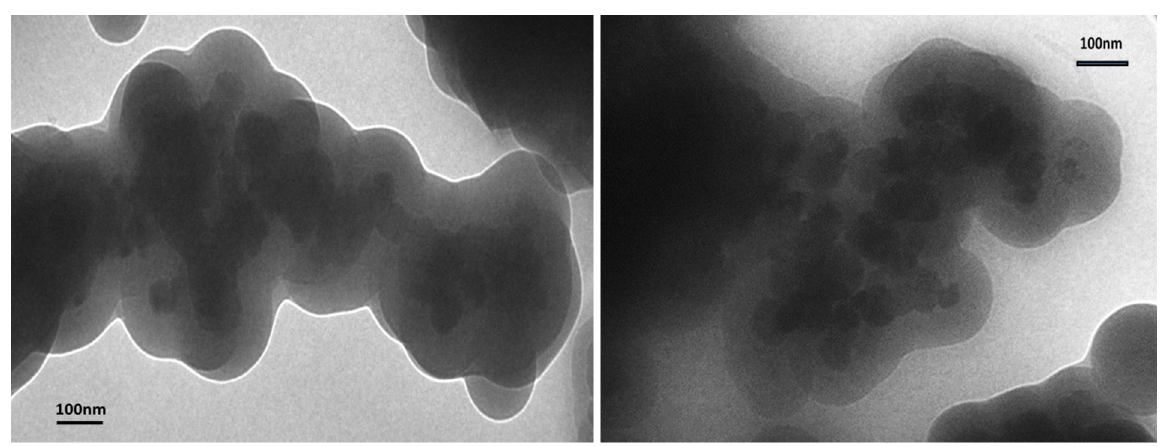
Figure 3. TEM images of the SiO 2 coated CoFe 2 O 4 nanoparticles.